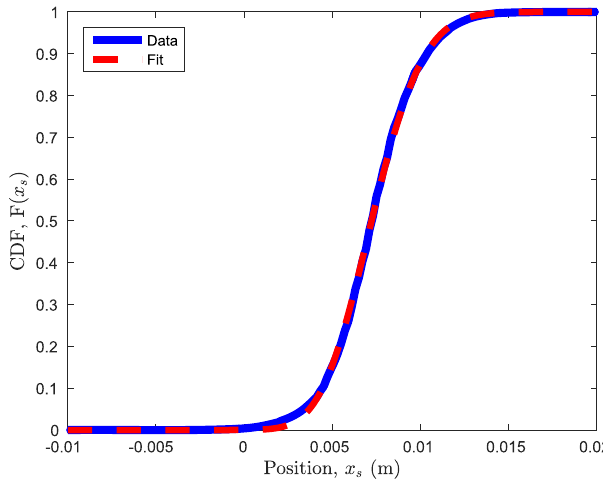
FIG. 7. Gaussian fit to a horizontal scraper scan at 100 keV, taking ϵ x and σ δ as free parameters.